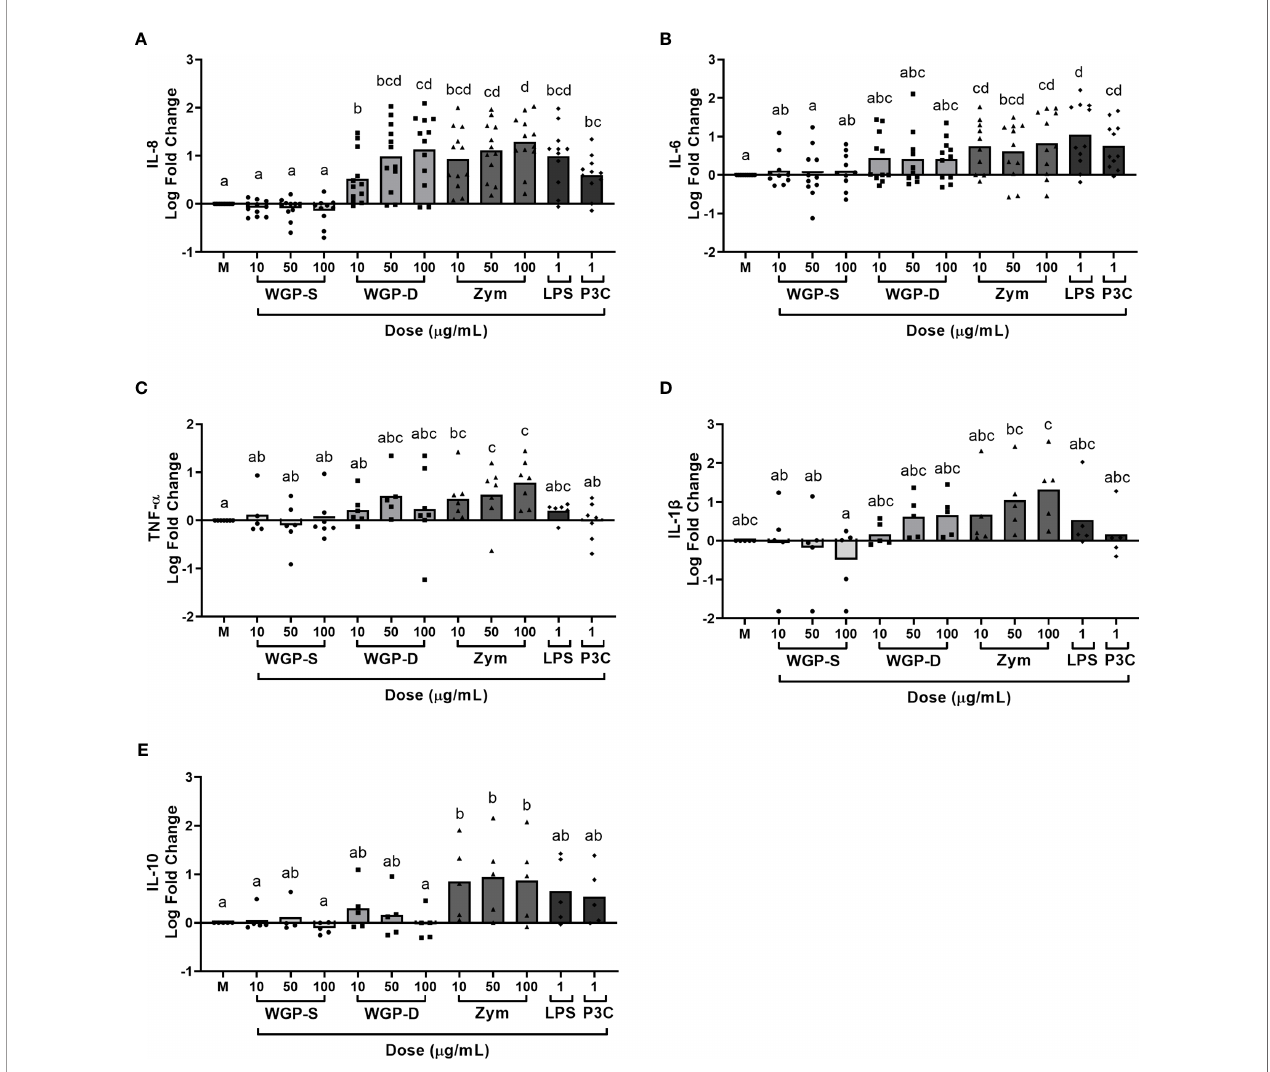
FIGURE 1 | Cytokine production evaluated by ELISA in the supernatants of bovine monocytes cultured for 24 h with WGP Soluble (WGP-S), WGP Dispersible (WGP-D), Zymosan (Zym), LPS, and Pam3csk4 (P3C). Data are presented as Log fold change relative to medium (M) and represent means of 12 animals for IL-8 (A) , 11 animals for IL-6 (B) , 7 animals for TNF- a (C) , and 5 animals for IL-1 b (D) and IL-10 (E) . Each symbol corresponds to a different animal. a,b,c,d Means with different superscript letters are signi fi cantly different ( P